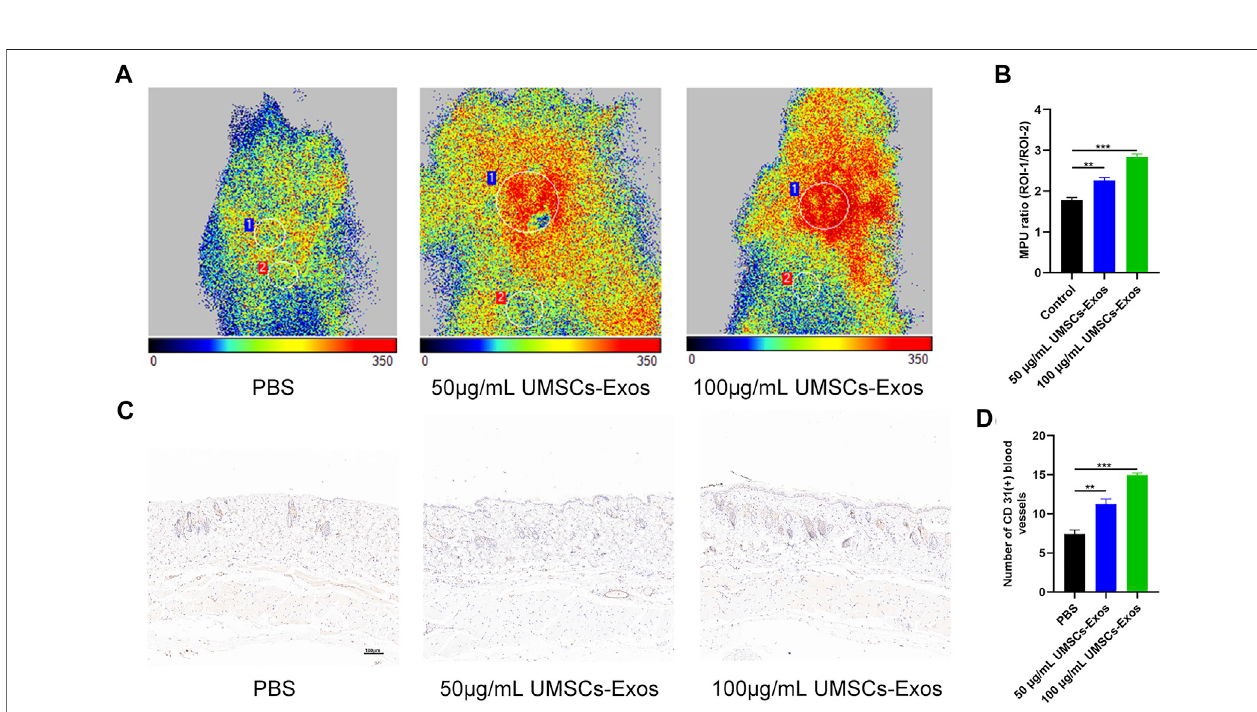
FIGURE 6 | HUC-Exos enhanced angiogenesis in vivo . Mice were treated with PBS, 50 μ g/ml of UMSCs-Exos, and 100 μ g/ml of UMSCs-Exos (n = 10). (A) The perfusionofthewoundareainthethreegroupswasassessedusingasmall-animalDoppleranalysis.Scalebar:100 μ m. (B) Quantitativeperfusionintensityofthewound area in the three groups. (C) Immuno fl uorescence assay with marker CD31 (+), n = 10. Scale bar: 100 μ m. (D) Fluorescence quanti fi cation of the wound length at day 14.Scalebar:50 μ m.Differencesweremeasuredbyone-wayANOVAfollowedbyaTukey posthoc testforpairwisecomparison.Datapresentedasmeans ± SD. **** p < 0.0001, *** p < 0.001, ** p < 0.01, and * p <